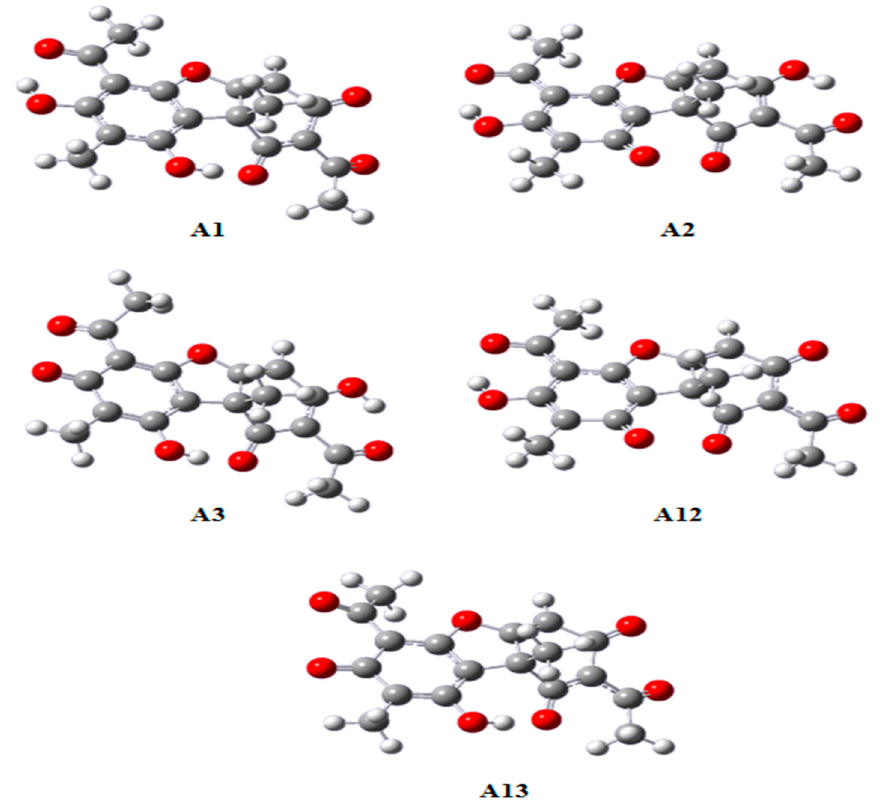
Figure 2. Equilibrium structures of usnic acid anions. A1, A2 and A3 formed after one single deprotonation and anions A12 and A13 formed after two deprotonations.